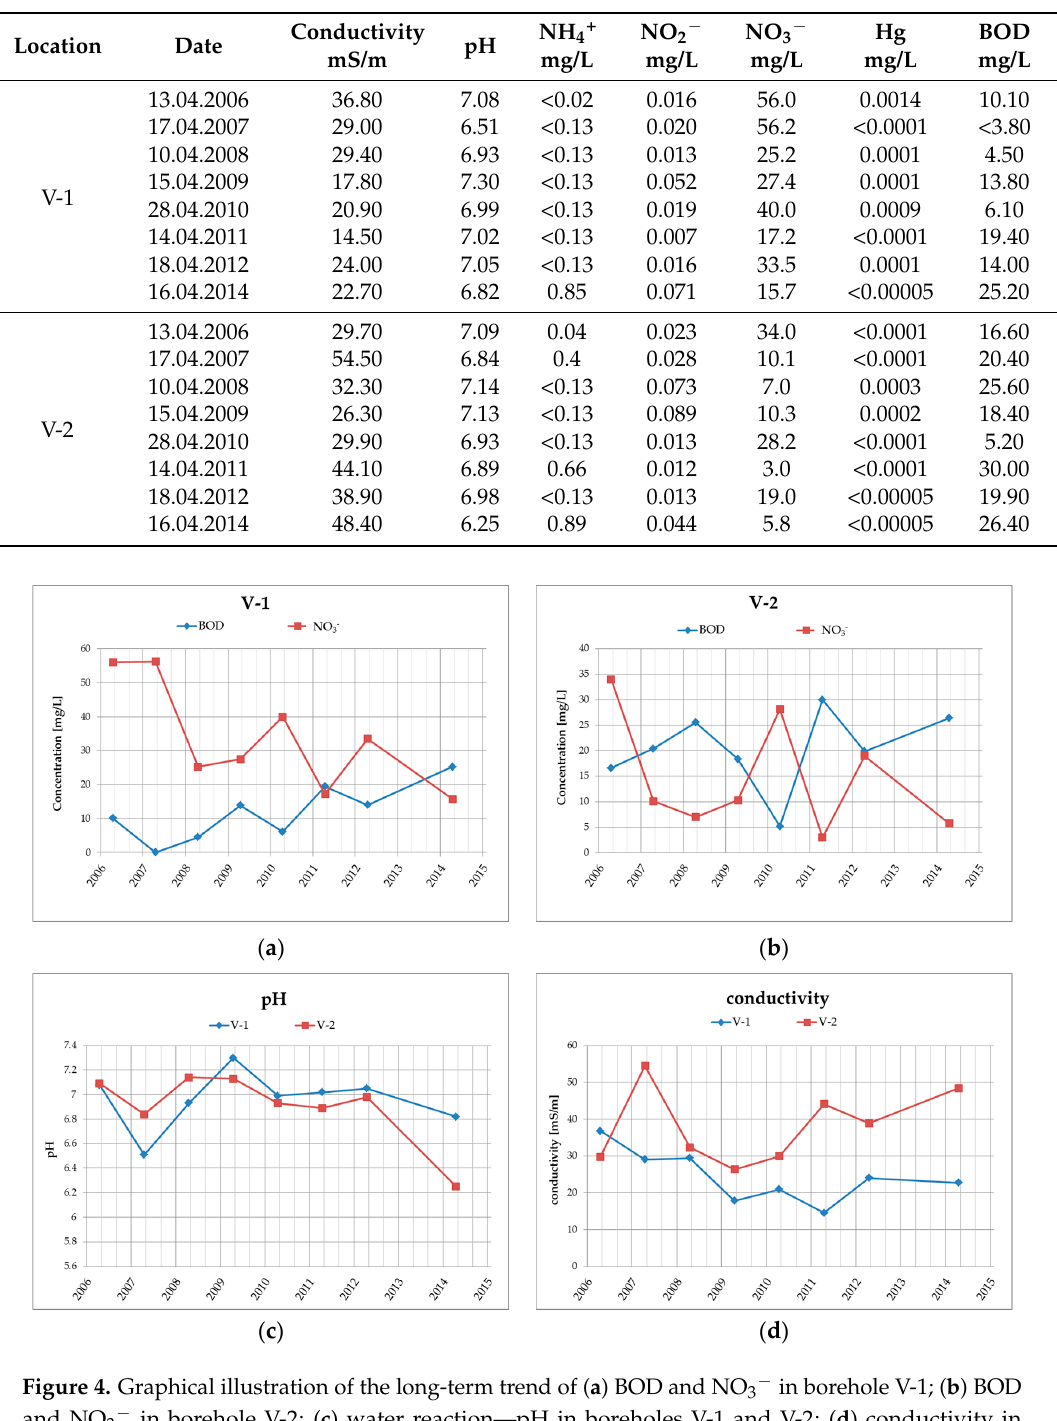
Table 2. Overview of selected results of groundwater quality monitoring during the period of 2006–2014 (the determination limit values of LOQ are presented in Table 1).